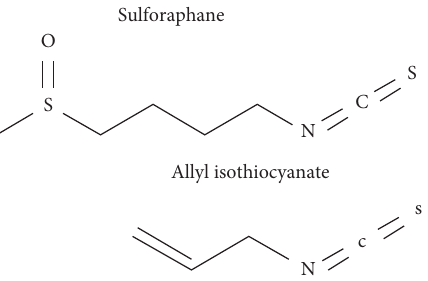
Figure 1: Structures of sulforaphane and allyl